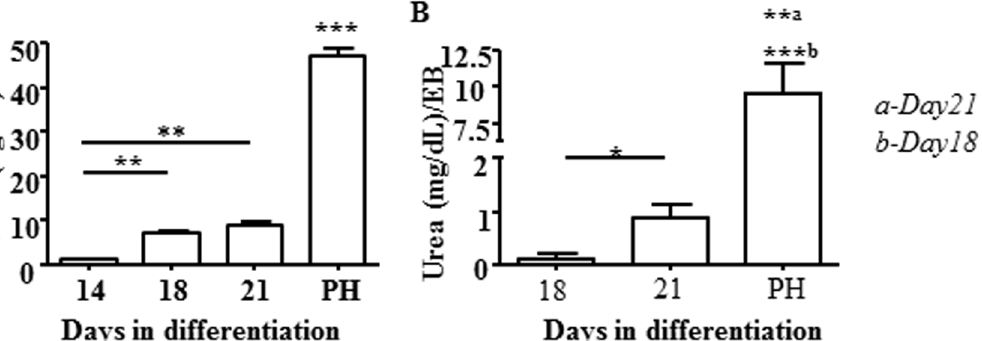
Fig 4. Assessment of functionality in vitro of Liv2-sorted GPSC-derived hepatocytes. Functionality was assessed by albumin secretion (A) and urea synthesis (B). Liv2-sorted GPSC- derived hepatocytes were analysed for the presence of albumin (A) and for the metabolism of ammonium chloride into urea (B) at 21 days of induced differentiation. Postnatal hepatocytes (PH) were used as positive control. Data shown are representative of 3 independent experiments performed in triplicate.